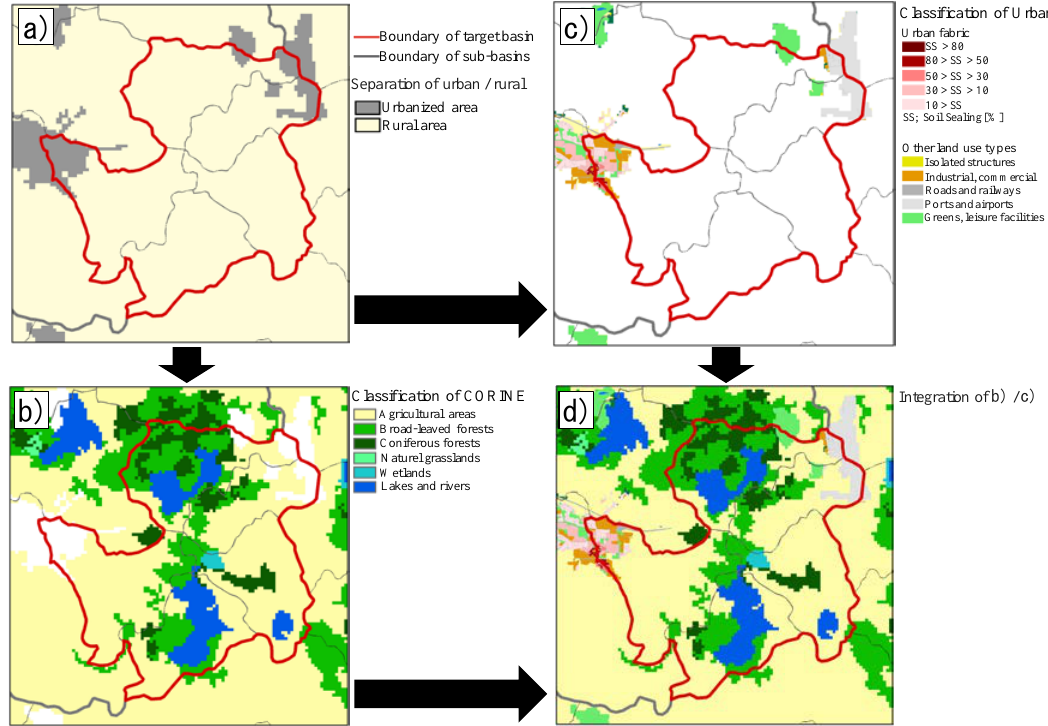
Figure 3. Procedure of land use data set-up by using EEA CORINE and EEA Urban Atlas. ( a ) Firstly, urban and rural areas in the study basin were separated. Here, the urban related land use classifications (continuous urban fabric, discontinuous urban fabric, Industrial, commercial, Green, leisure facilities, roads, railways, ports, and airports) in CORINE are merged into urbanized area, and the other land use classifications are integrated as rural area. ( b ) Rural area was classified by CORINE land use classifications. ( c ) Internal urbanized area was classified by Urban atlas. ( d ) Finally, Land surface data for HYPE modelling was constructed by integration of ( b ) and ( c ).